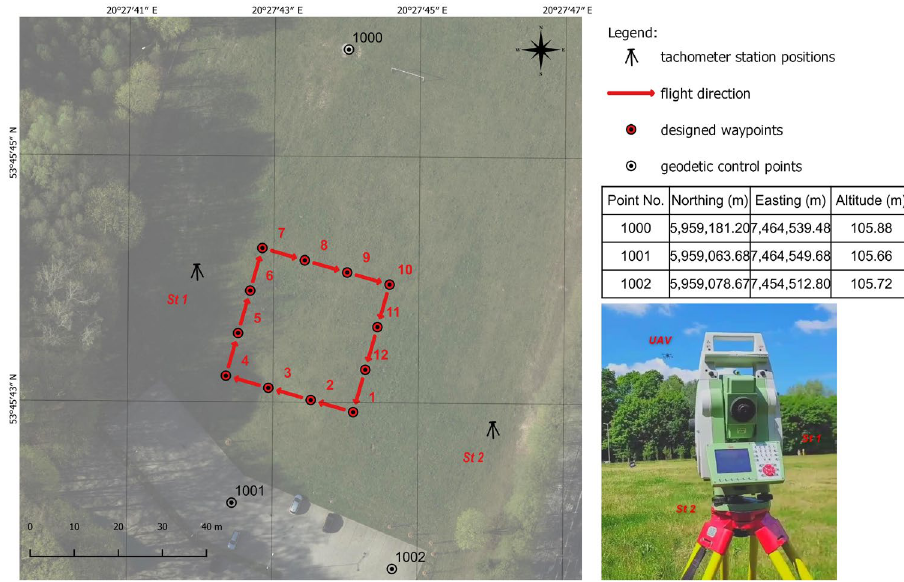
F igure 4. Planned UAV mission . Figure 4. Planned UAV